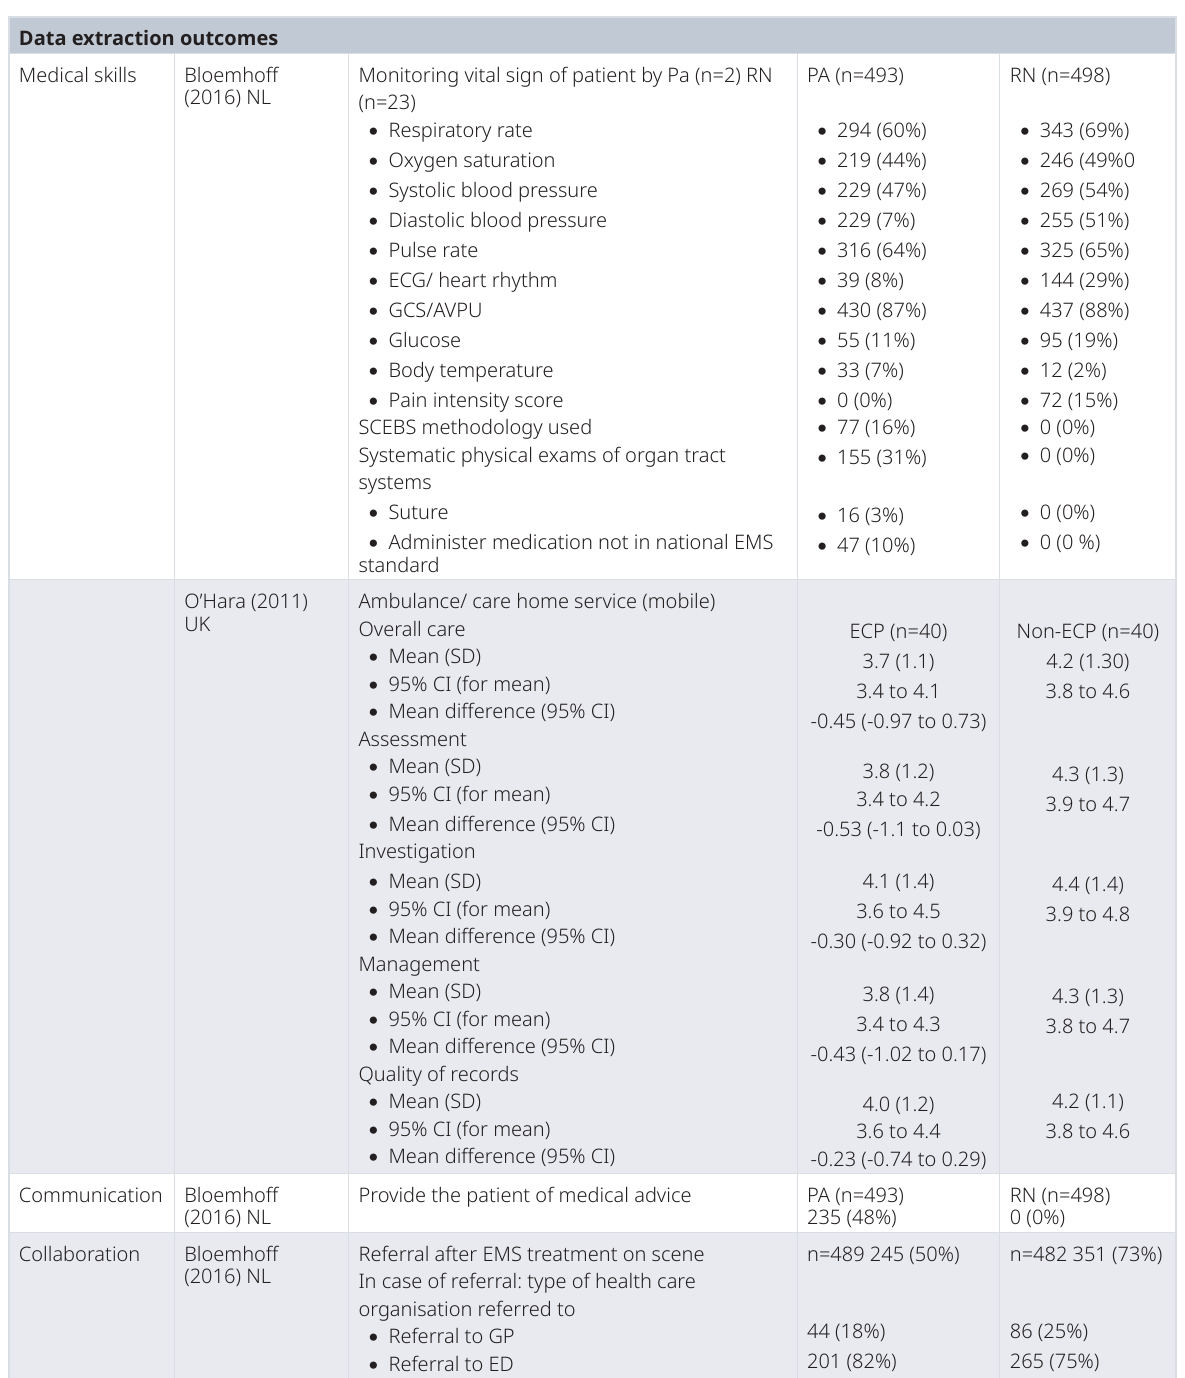
Table 2. Activities by a NP or